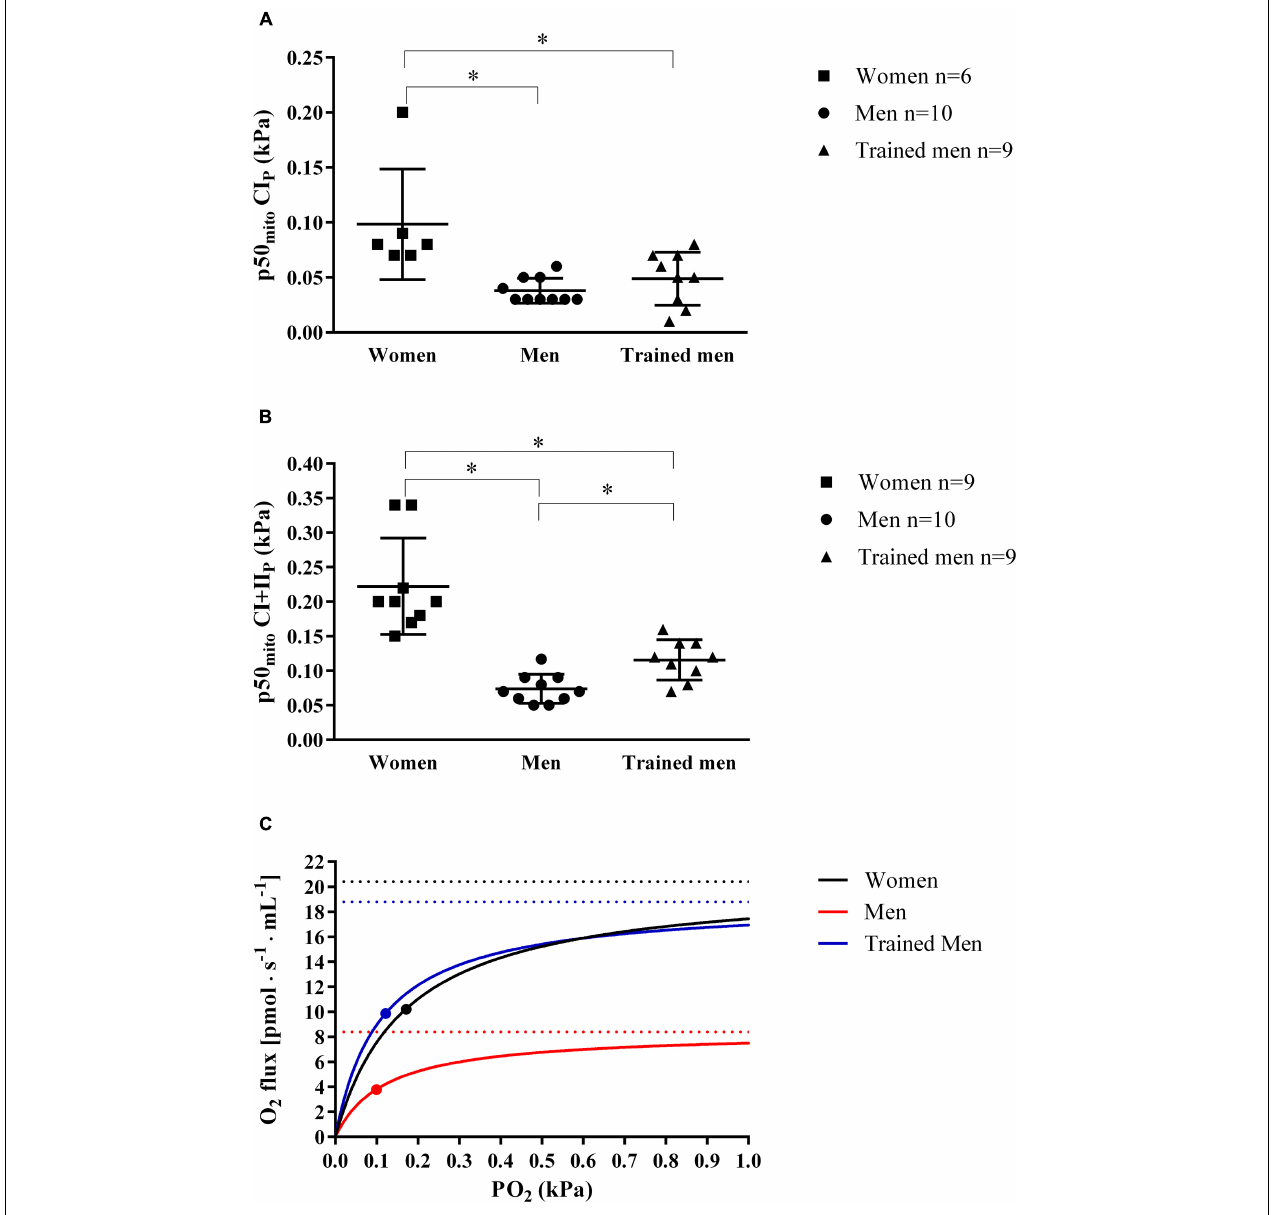
FIGURE 2 | (A) Individual and mean ± SD values of ex vivo mitochondrial p50 (p50 mito ; kPa) at maximal ADP-induced activation measured in isolated mitochondria when activating complex I (CI P ) for women, men, and trained men groups. (B) Individual and mean ± SD values of ex vivo p50 mito as shown in A , but with complex I + II-linked substrate state (CI + II P ) for women, men, and trained men groups. ∗ p < 0.05 between groups. (C) Hyperbolic curves showing the relation between PO 2 (kPa) and mitochondrial